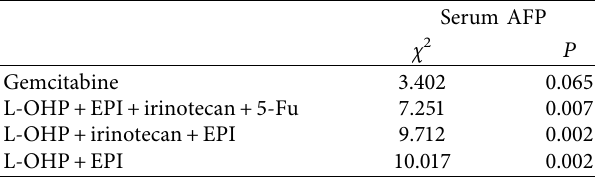
Table 7: Relationships between serum AFP and drug